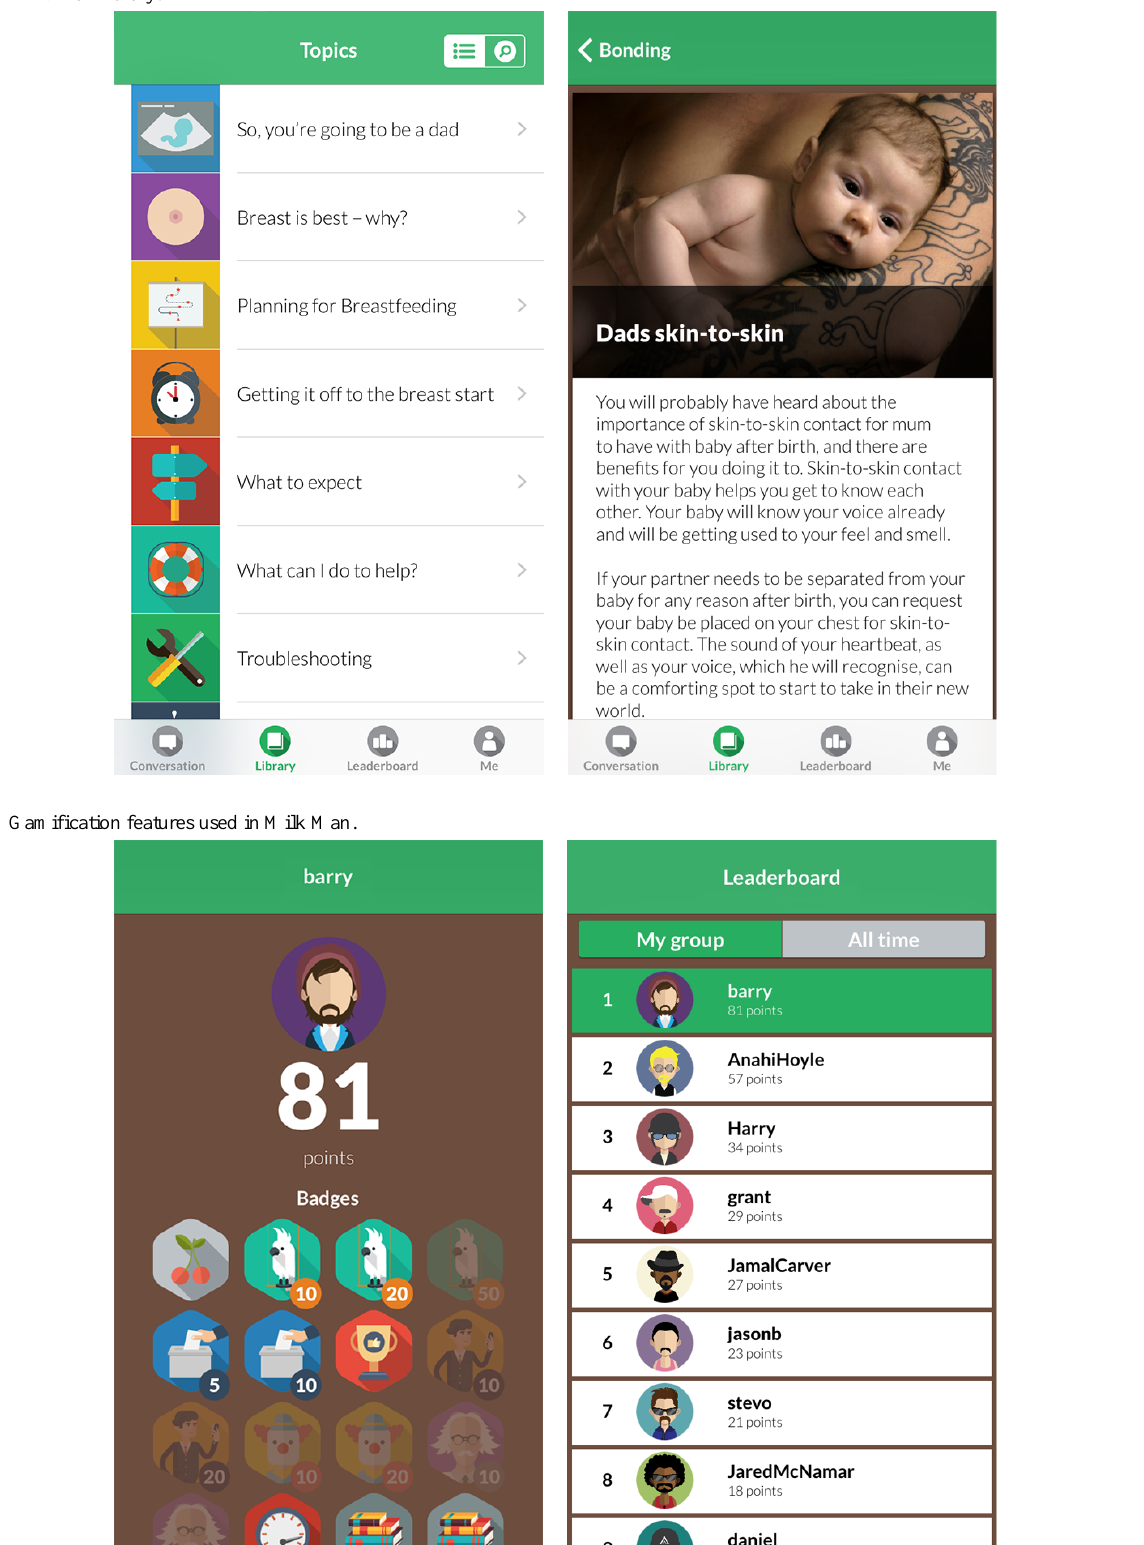
Figure 3. Milk Man library.